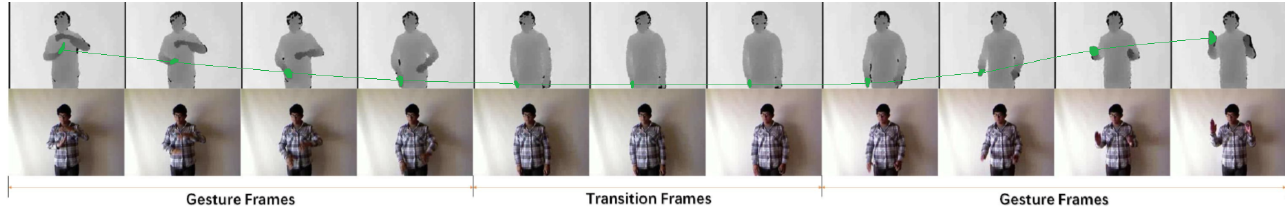
Figure 1. The sample gesture sequence. A continuous gesture sequence is composed of gesture frames and transitional frames between two gestures. We found that both the appearance information and hand motion information are useful for temporal segmentation.